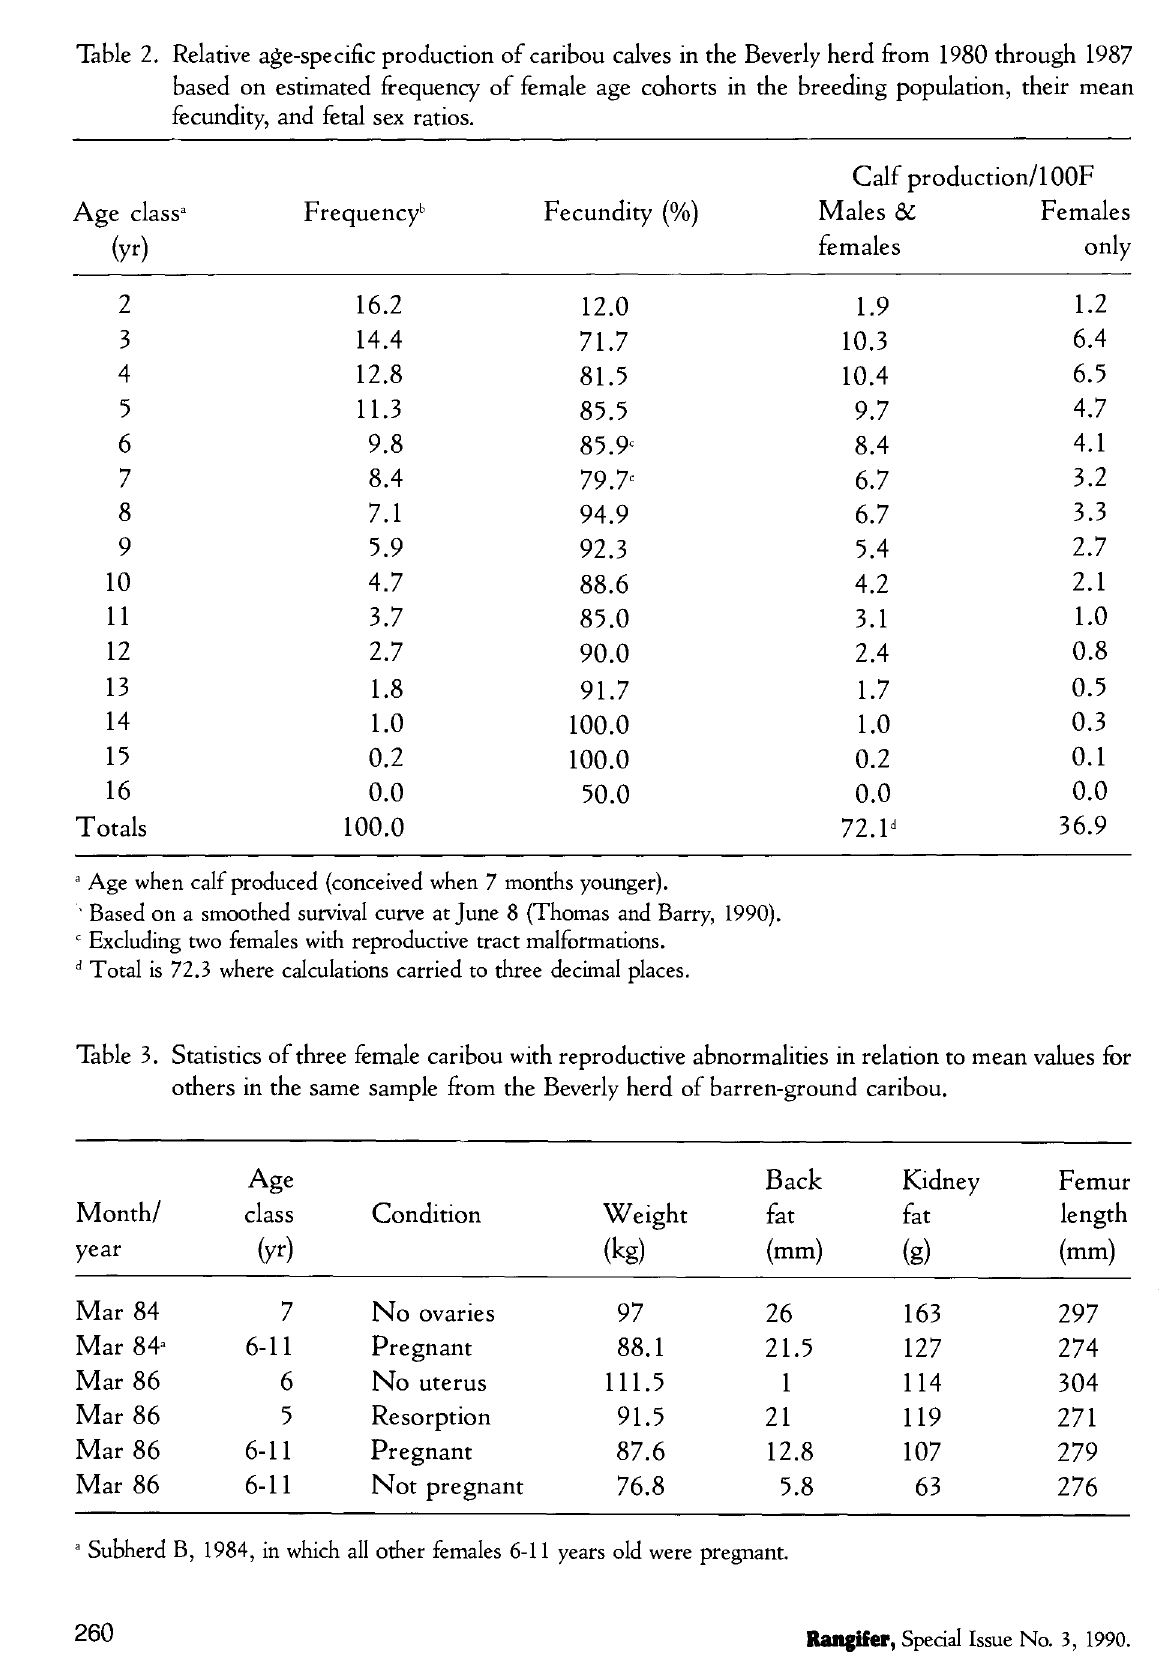
Table 2. Relative age-specific production of caribou calves in the Beverly herd from 1980 through 1987 based on estimated frequency of female age cohorts in the breeding population, their mean fecundity, and fetal sex ratios.